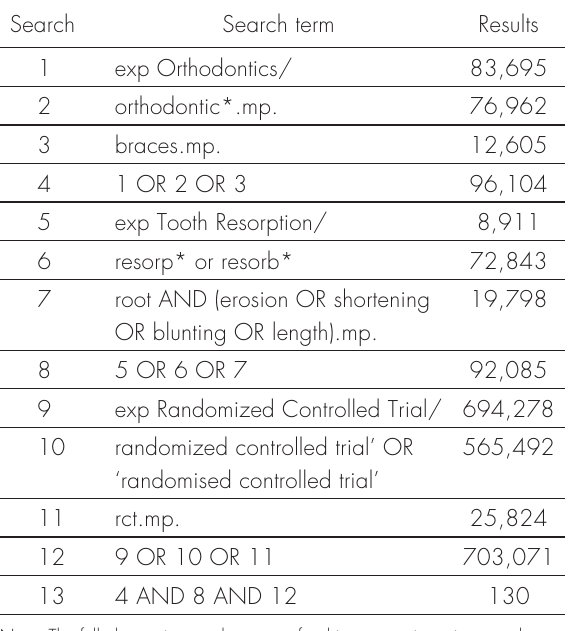
Table I. The full electronic search strategy for the Table I. Search strategy for PubMed.